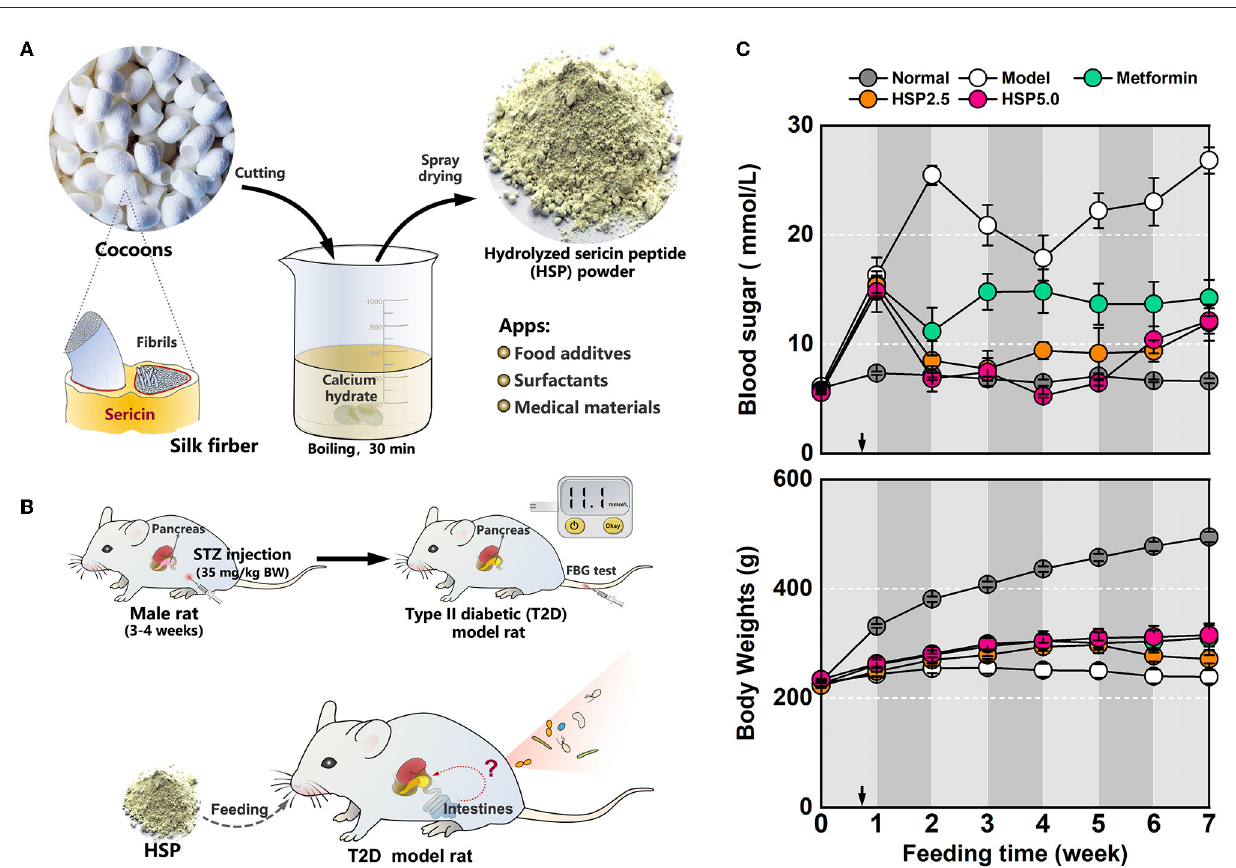
FIGURE1 Dietary administration with hydrolyzed sericin peptide (HSP) in T2D model rats. (A) Schematic of HSP processing. (B) T2D model preparation and HSP dietary administration. (C) Measurement of body weights and FBG levels. The measured values are presented as mean ± standard error.